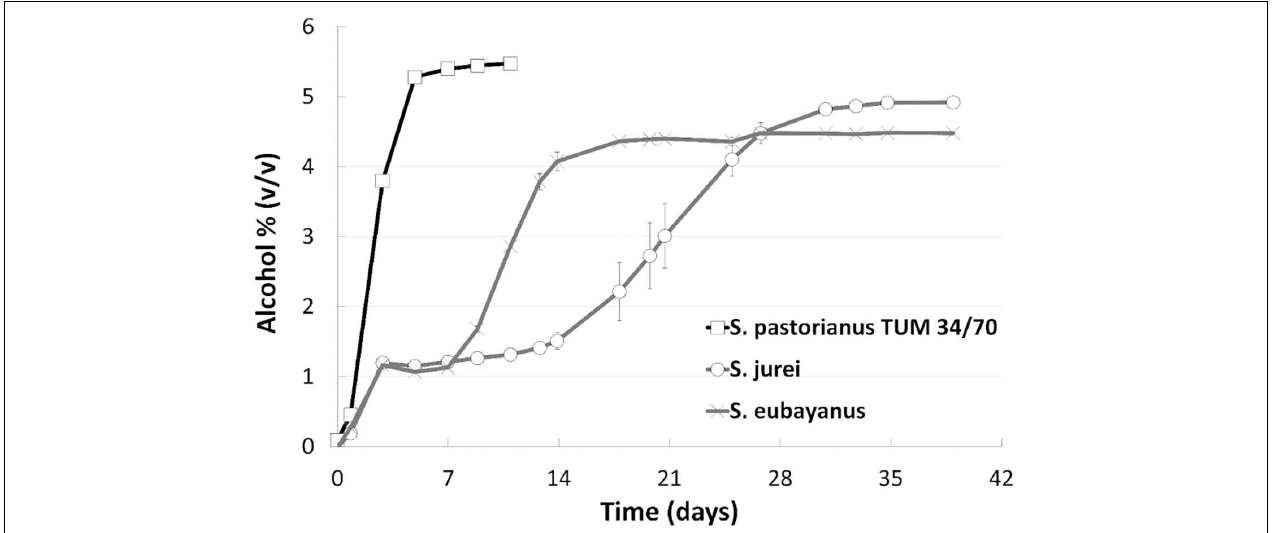
FIGURE 3 | Fermentation progress as monitored by alcohol level (v/v) at 15 ◦ C during 39 days of fermentation of an all-malt 12 ◦ P wort. Strains include one lager reference strain (TUM 34/70), as well as the German strain of S . jurei (TUM 629), and the type strain of S . eubayanus (C902). Values are means from duplicate fermentations and error bars indicate